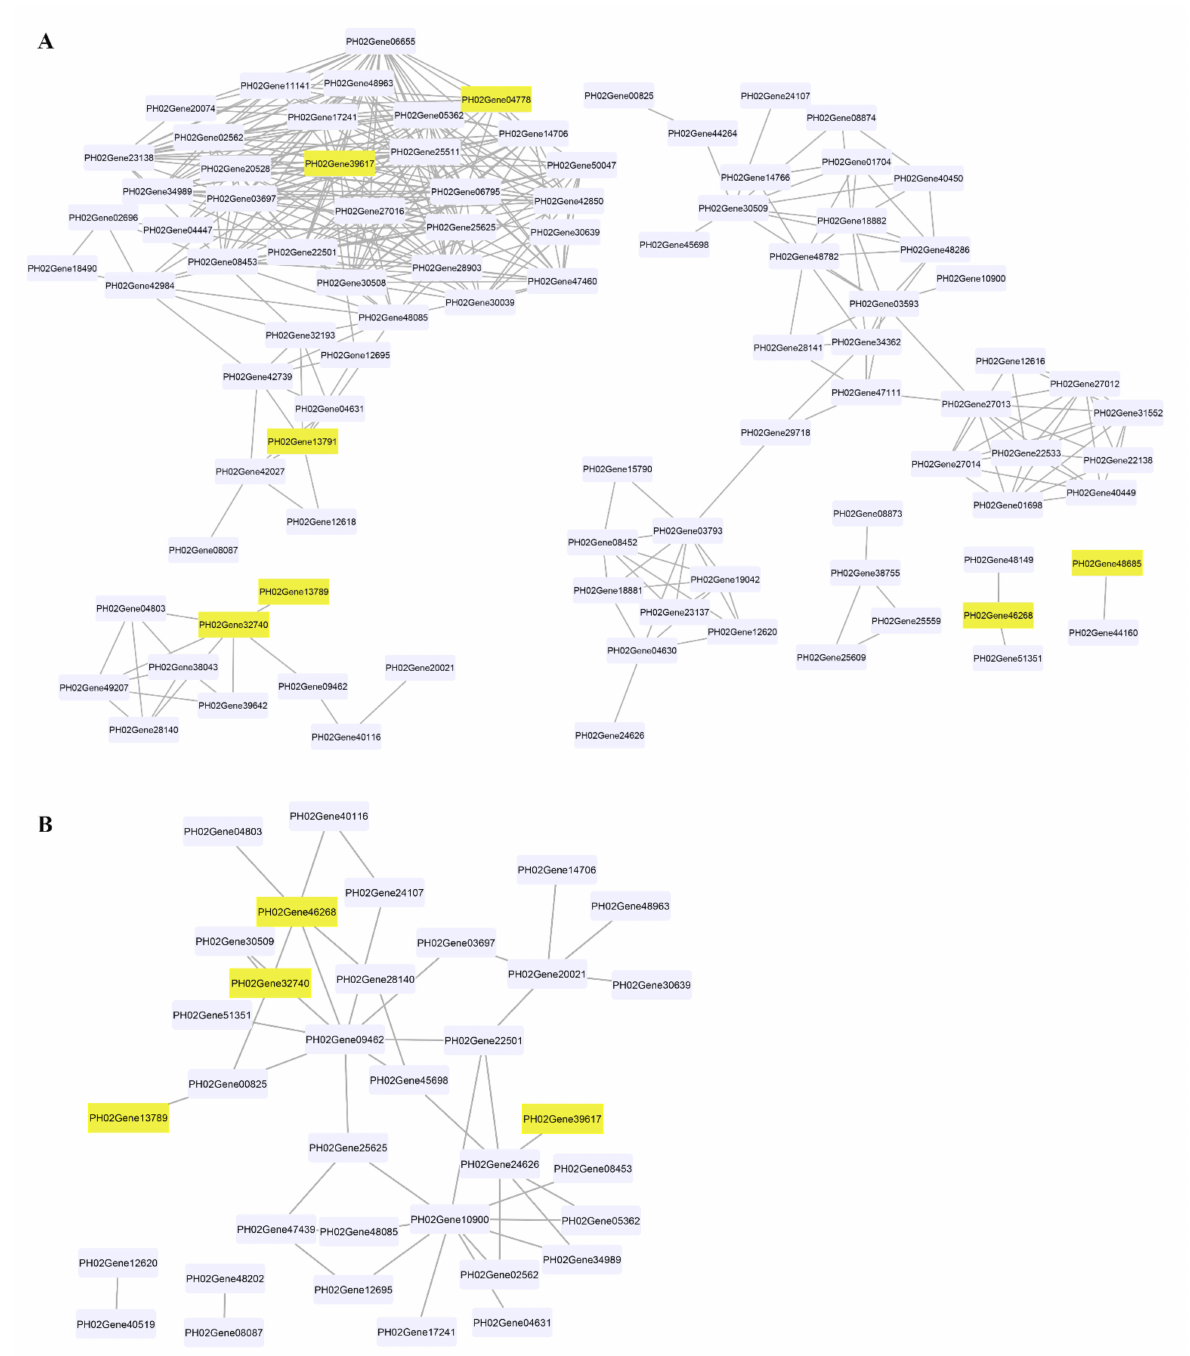
Figure 4. Co-expression network of PheCAD genes with lignin biosynthesis pathway genes. ( A ) Positive correla- tion of PheCAD genes with lignin biosynthesis pathway genes; ( B ) negative correlation of PheCAD genes with lignin biosynthesis pathway genes. Pink-coloured boxes indicate the PheCAD genes and violet boxes indicate the other lignin biosynthesis